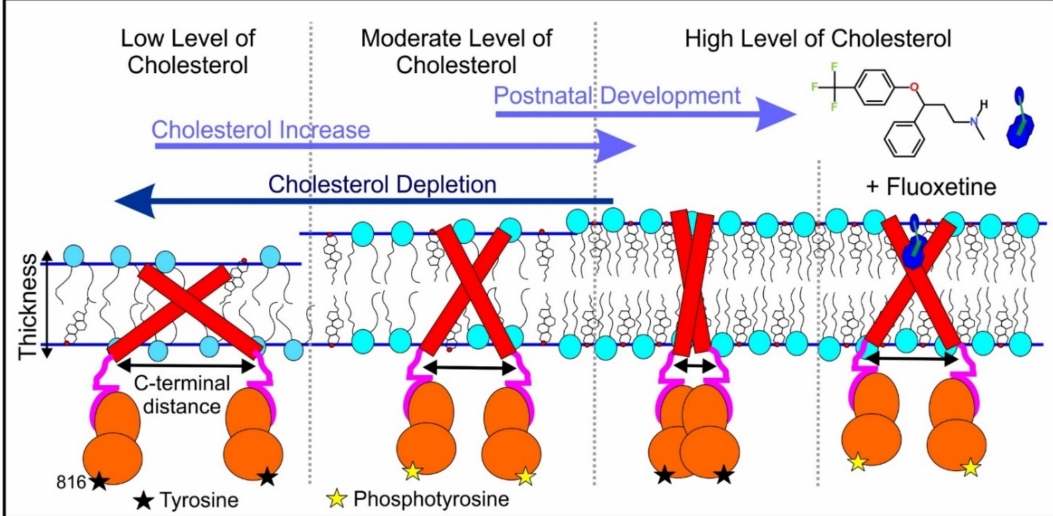
Figure 24. Schematic representation of how cholesterol and antidepressants regulate the activity of TRKB receptors through driving the orientation of its transmembrane helices. The rise of cholesterol content in the membrane increases its thickness. This forces the transition of TRKB transmembrane dimers towards the states with shorter C-terminal distances between the ends of the helixes (red rectangles). In turn, the C-terminal distances determine the arrangement of TRKB kinase domains (shown in orange) and the phosphorylation states of tyrosine 816 (black and yellow stars for native and phosphorylated states, respectively). The antidepressant fluoxetine (shown in blue), when bound to the pocket, preserves the stable transmembrane dimer conformation in a similar fashion to that observed at moderate cholesterol level and optimal for receptor